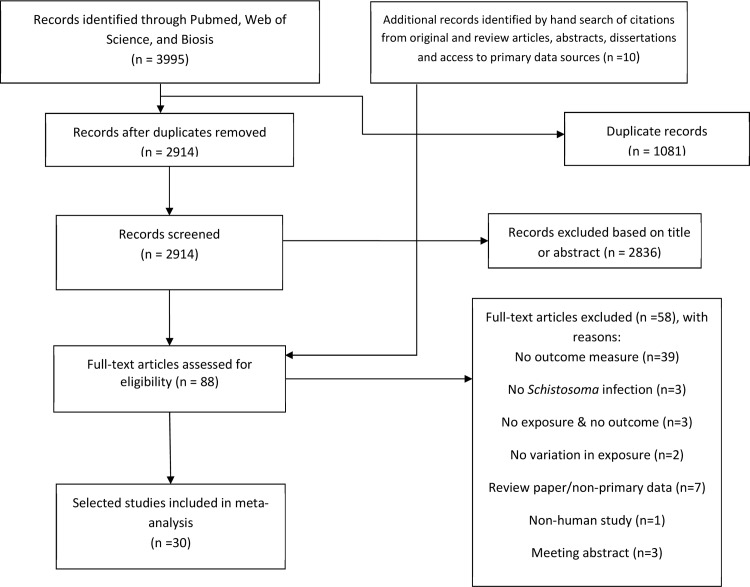
Flow diagram for search and selection of included studies.